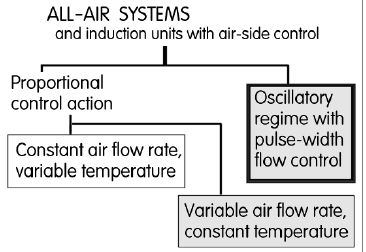
Fig. 3 The character of control by jet switching in fluidic valves prefers operating the fluidic terminal units in the oscillatory PWM mode